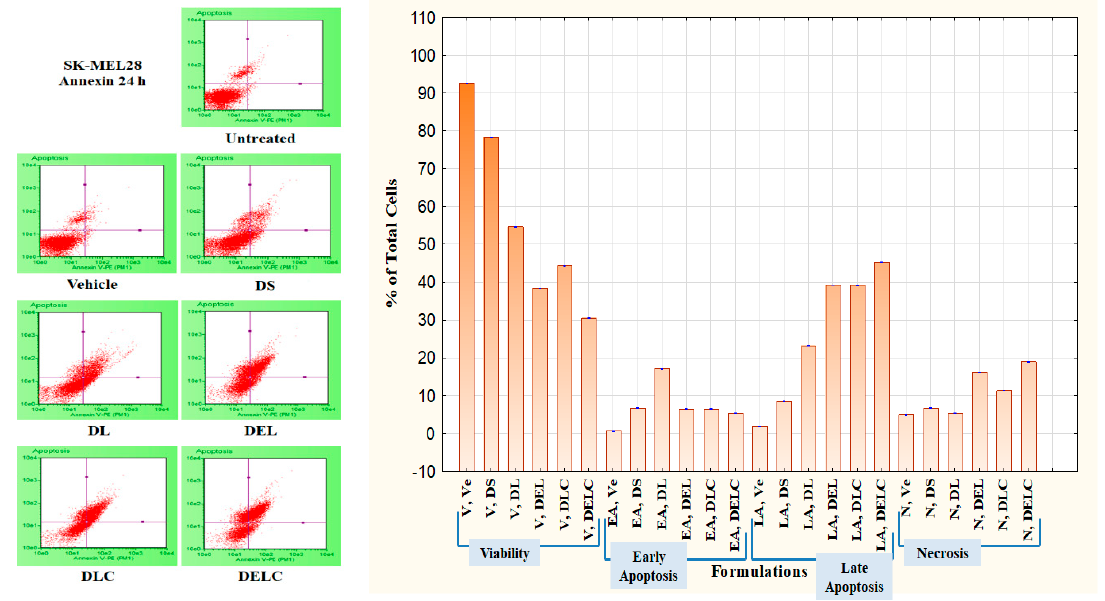
Figure 14. Apoptosis in SK-MEL-28 Melanoma cells. Pharmaceutics 2018 , 10 , x FOR PEER REVIEW